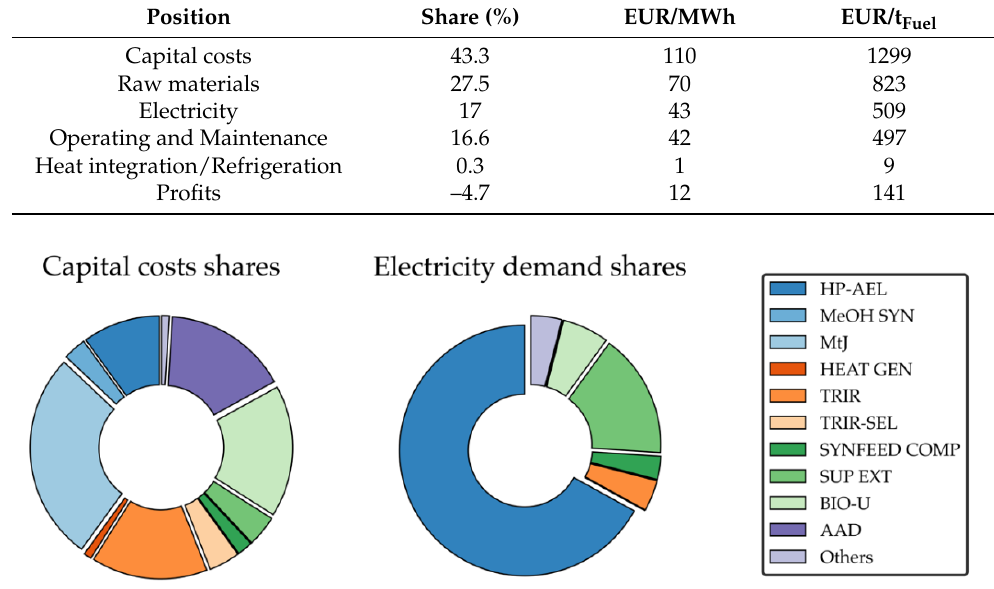
Figure 14. Capital cost and electricity demand breakdown of renewable refinery base case optimi- zation.